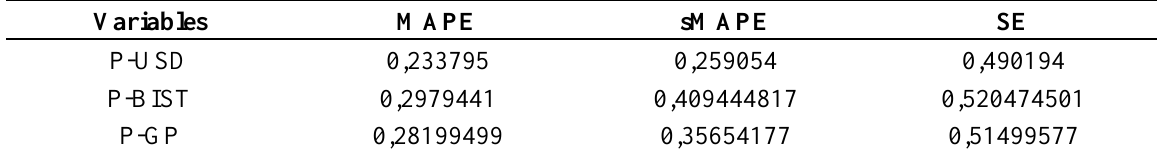
Table 1. Some symmetry measures with the whole results of the second ANN output variables.